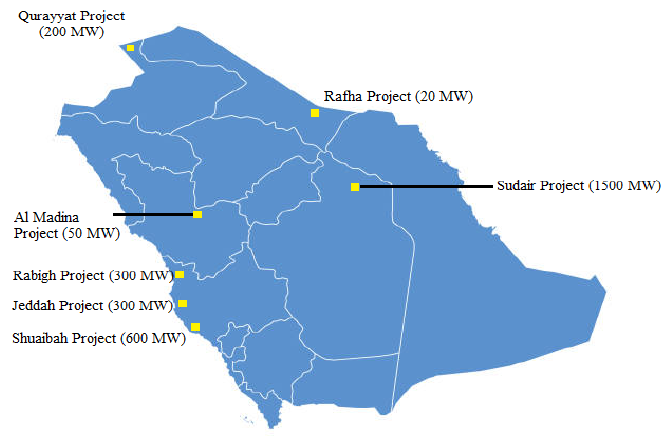
Figure 2. Location of seven new solar PV projects [7].